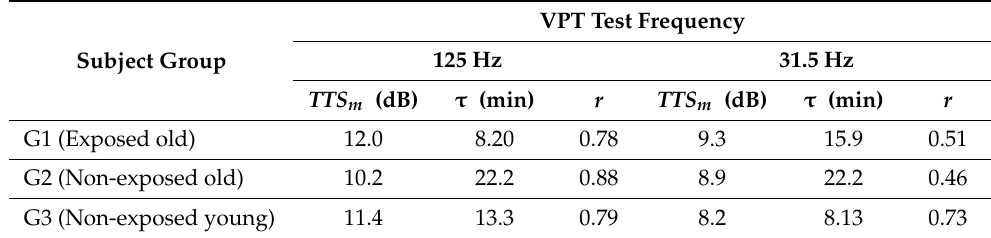
Table 6. Parameters of TTS recovery calculated from the vibrotactile perception test performed after exposure to high